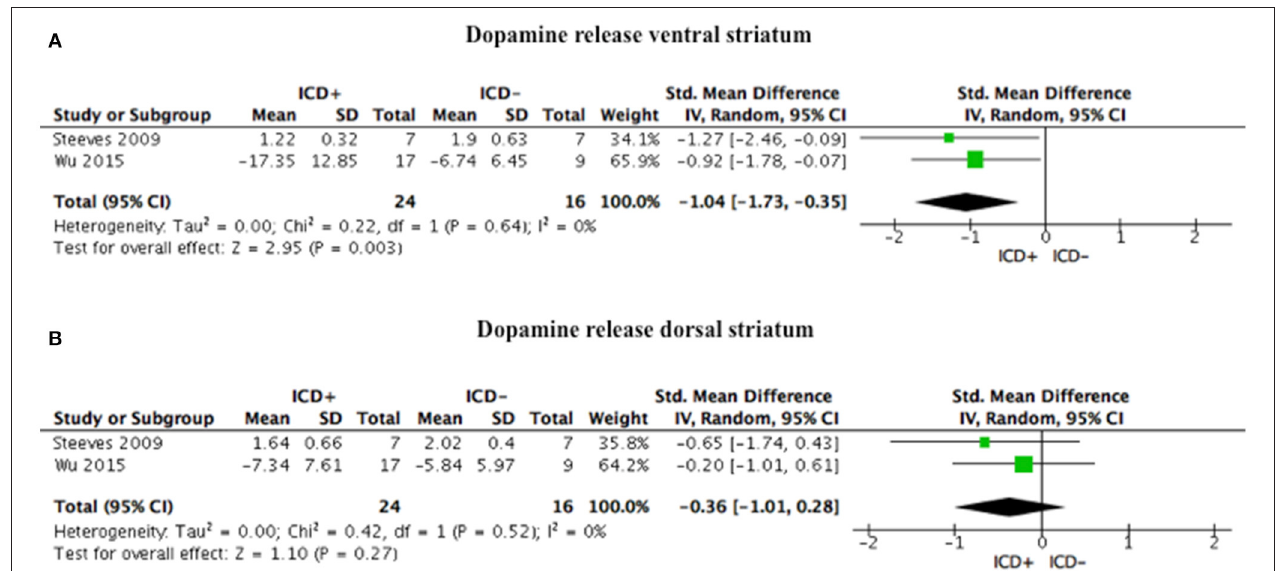
FIGURE 3 | Forest plots for dopamine release. Here are reported forest plots for dopamine release in the ventral striatum (A) , and in dorsal striatum (B) . Standardized mean difference represents Hedges’s g effect size. The size of the square indicates the weight of the study. The horizontal line represents the 95% confidence interval. The diamond represents the pooled effect size. Negative effect sizes indicate lower dopamine release in PD patients with ICD (ICD + ) in comparison to those without ICD (ICD–). ICD, impulse control disorder; PD, Parkinson’s disease.